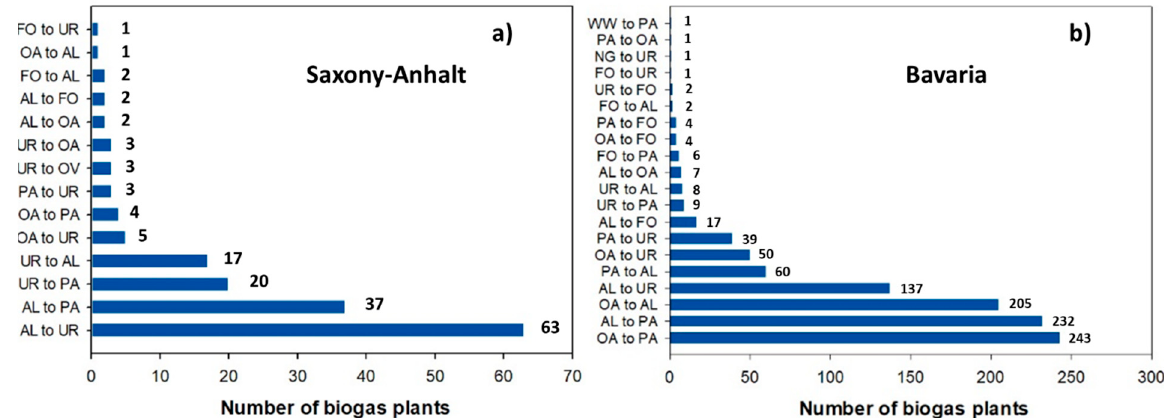
Figure 4. The detected biogas plant locations with land-use change during 2000–2018 in federal states of a) Saxony-Anhalt and b) Bavaria. Source: EE-Monitor, CLC 2000, and CLC 2018.